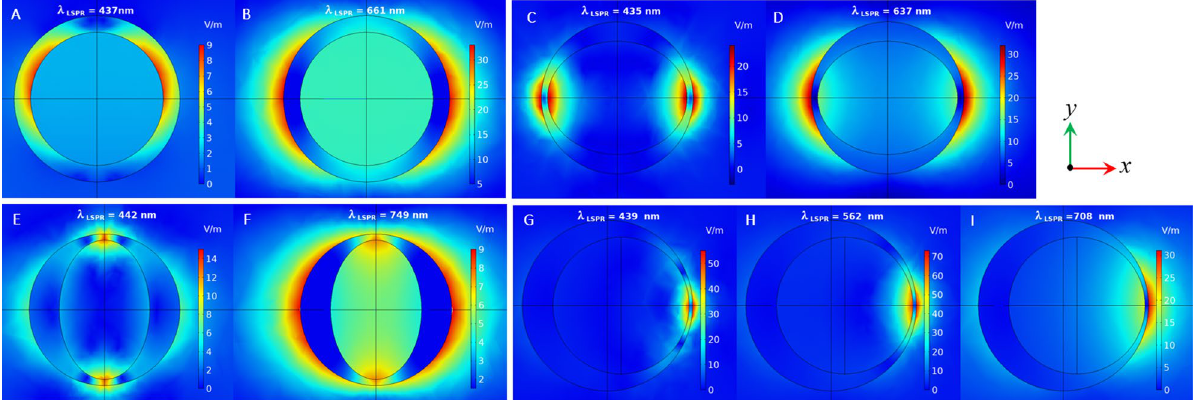
Figure 3. Electric field distribution of ( A , B ) CS, ( C , D ) PS and ( E , F ) OS at ABM and BM, respectively. ( G , I ) Electric field distribution of NE at ABM, MM and BM, respectively.